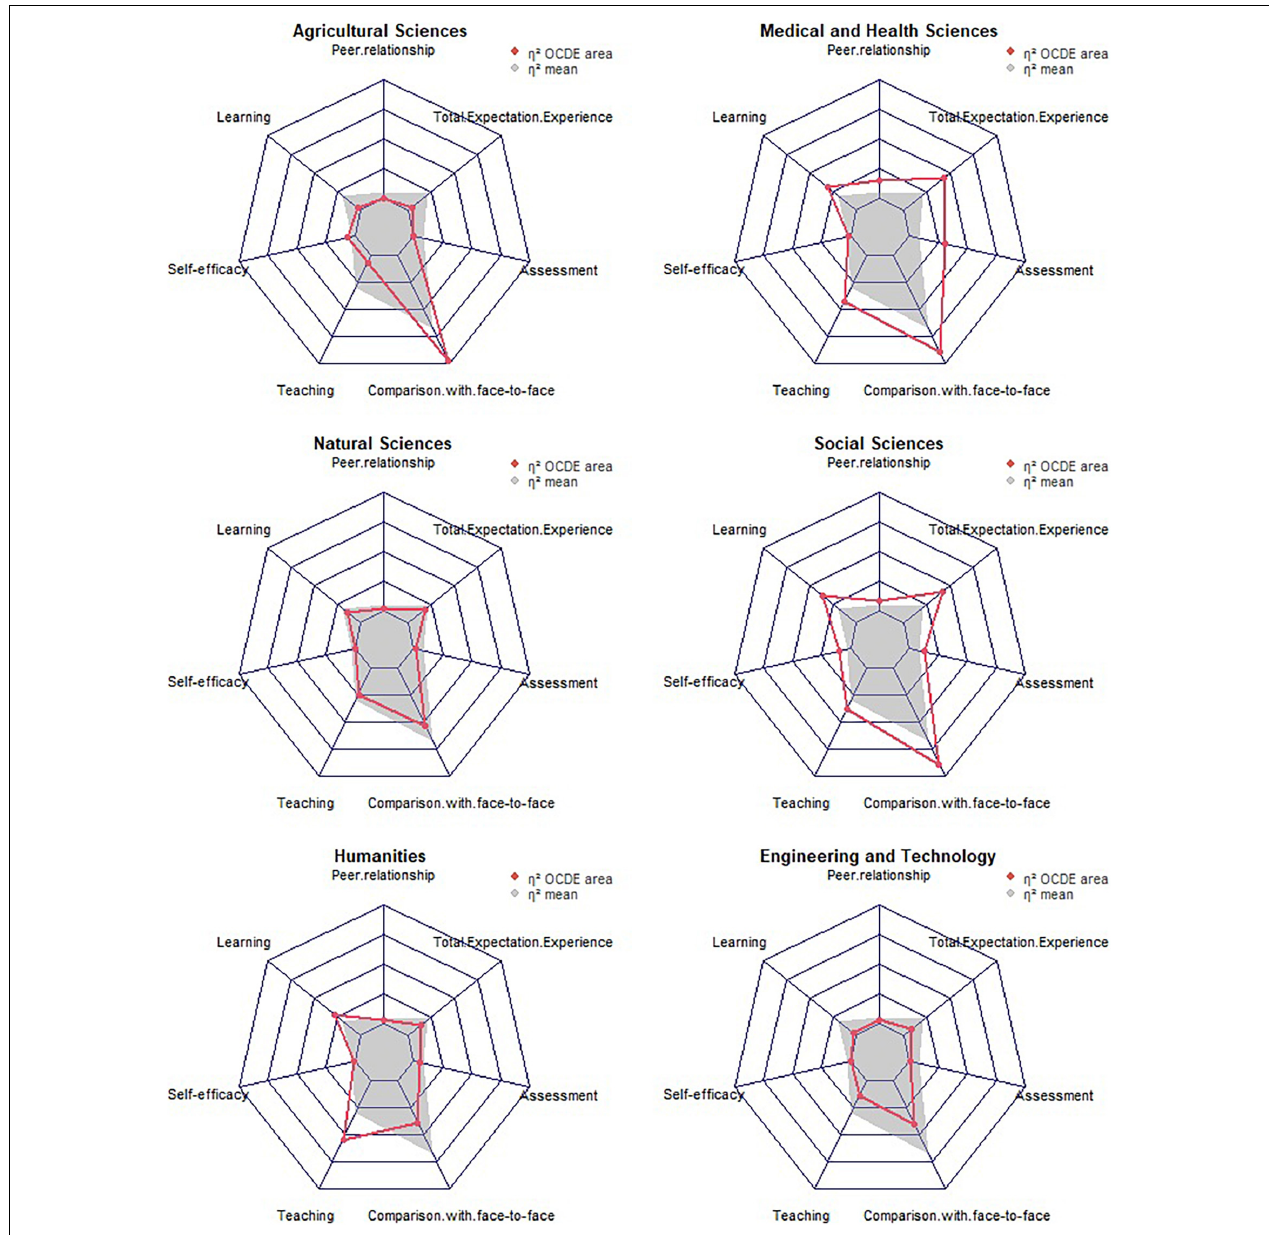
FIGURE 2 | Size effect regarding the change between expectations and experience according to the disciplinary